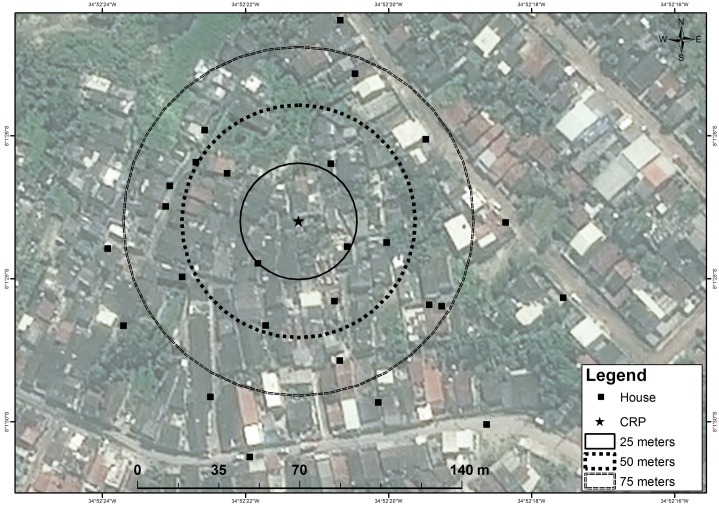
Mosquito mark release recapture (MMRR) collection points via handheld aspirators, Sítio Novo, Olinda, RMR, Brazil, July 22–August 21, 2015.